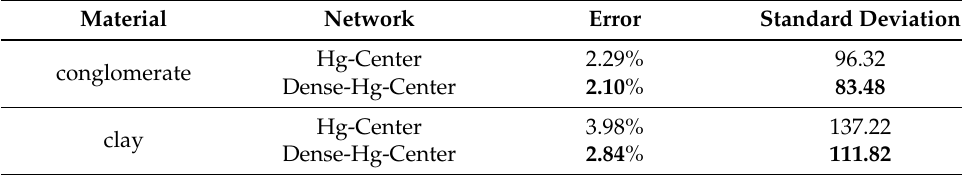
Table 2. Ablation experimental results for dense